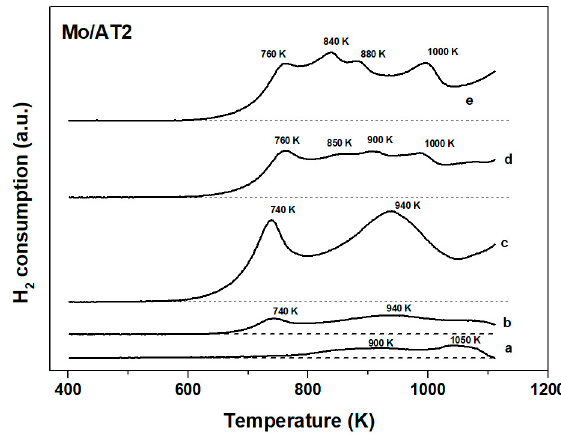
Figure 5. TPR profiles for unpromoted Mo/AT2 catalysts calcined at 673 K at different Mo loadings. ( a ) AT2, ( b ) 5 wt.%, ( c ) 10 wt.%, ( d ) 15 wt.%, and ( e ) 20 wt.%.